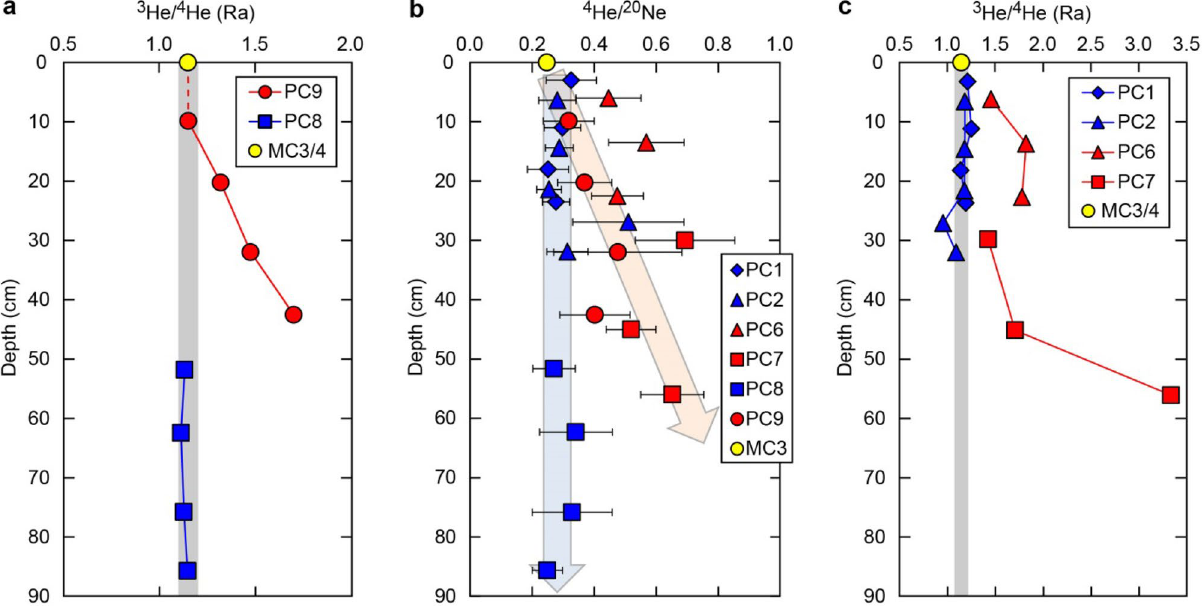
Figure 2. Depth profiles of 3 He/ 4 He and 4 He/ 20 Ne ratios at sites PC1–PC9, MC3, and MC4. ( a ) 3 He/ 4 He ratios on the Miyagi transect (line A4). Vertical gray zone marks the 3 He/ 4 He ratio of ca. 1.15 Ra, which